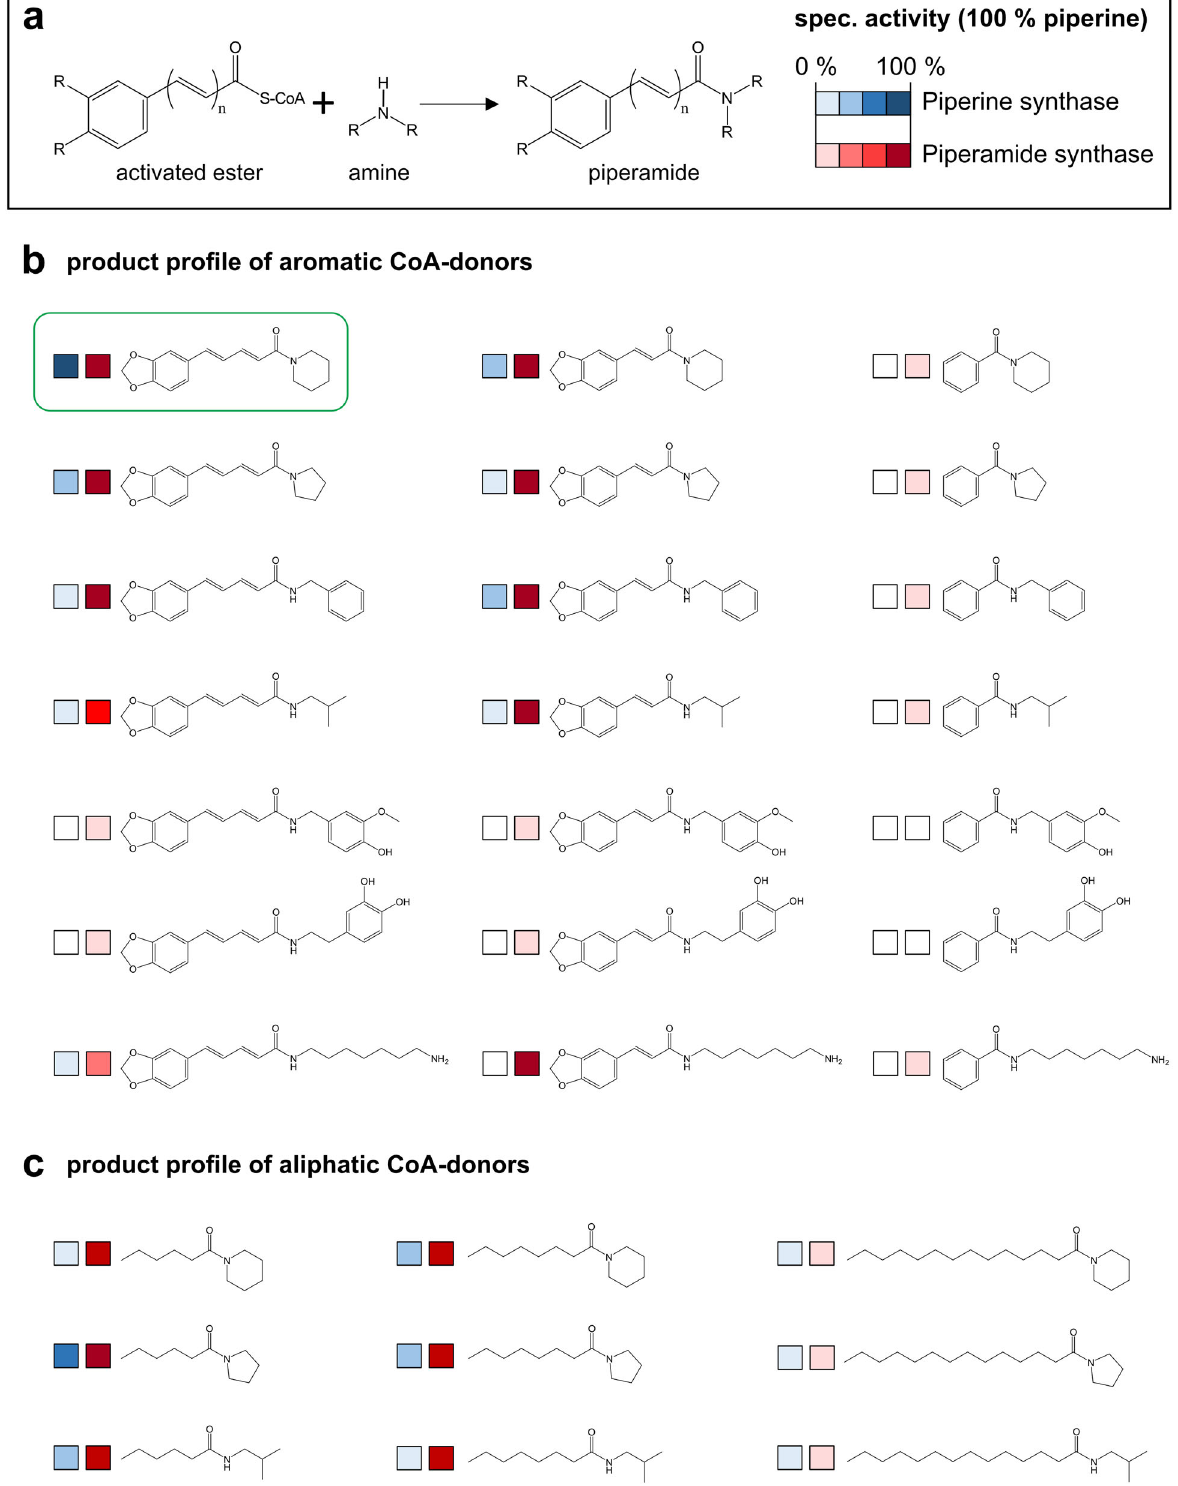
Fig. 5 Metabolic grid of a large set of amides produced by piperine synthase (blue) and piperamide synthase (red). a Color intensity of catalyzed reaction is correlated to relative enzyme activity based on LC-UV/Vis and LC-ESI-MS intensities. Relative activities are shown compared to piperine formation, set to 100%, shades of blue piperine synthase, shades of red piperamide synthase. Due to the lack of available standards, and individual, different ionization intensities, relative rather than absolute values can currently be provided with con fi dence. The combination of CoA-esters and different amines resulted in the production of a large array of amides. b Aromatic amides; c Aliphatic amides. Piperine synthase appears quite speci fi c for piperoyl- CoA and piperidine, whereas piperamide synthase is substrate promiscuous and tolerates a variety of amines and